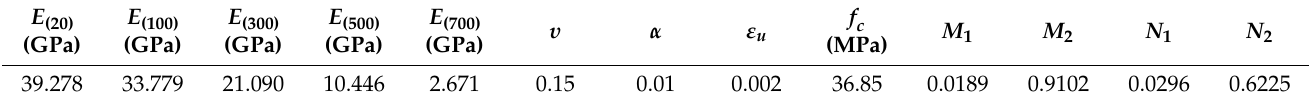
Table 2. Constitutive model parameters for C40 concrete.